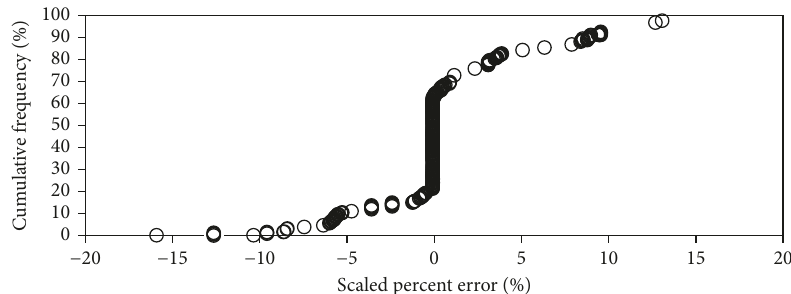
Figure 8: Scaled percent error of the BPN predicted from the ANN-2 model.